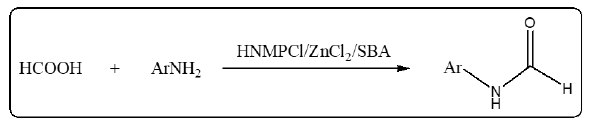
Figure 7: N-formylation of variety of amines. e